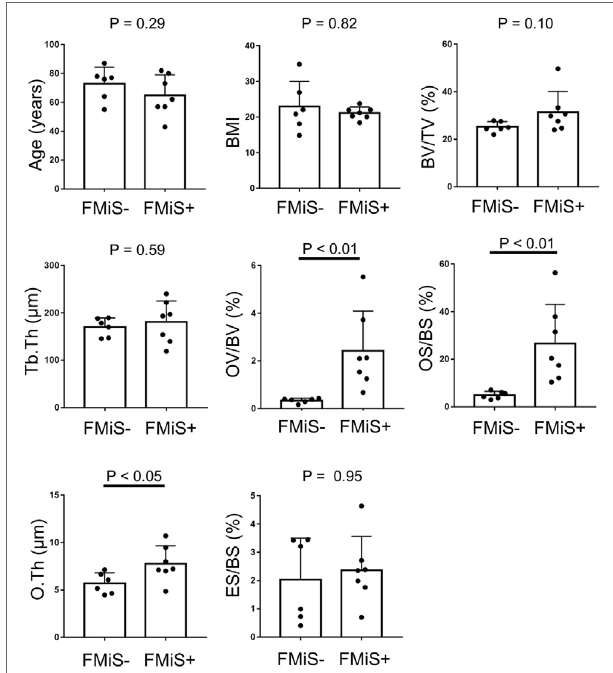
FigUre 4 | Comparison between FMiS-positive and -negative specimens from patients with RA. FMiS-positive (FMiS + ) group showed significantly higher values in bone histomorphometric data (OV/BV, OS/BS, and O.Th) compared with FMiS-negative group (FMiS − ). Data are mean ± SD. Abbreviations: FMiS, forming minimodeling structure; BMI, body mass index; BV, bone volume; TV, tissue volume; Tb.Th, trabecular thickness; OV, osteoid volume; BV, bone volume; OS, osteoid surface; BS, bone surface; O.Th, osteoid thickness; ES, eroded